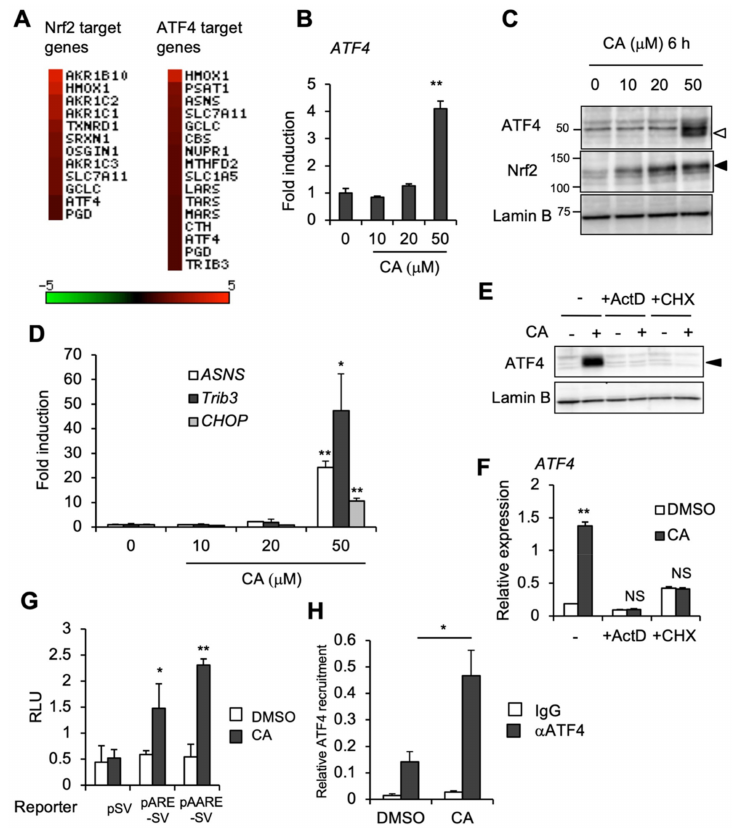
Figure 2. CA activates the ATF4 pathway in a dose-dependent manner in U373MG cells. ( A ) Heat map representation of genes induced by 50 µ M of CA in U373MG cells. The fold induction (CA vs. DMSO) was plotted based on microarray data. ( B ) Dose-dependent induction of ATF4 mRNA. ATF4 mRNA expression was evaluated by RT-qPCR and presented as the mean ± SE from three independent experiments. Each value was normalized to cyclophilin A expression. The asterisks indicate a significant increase compared with the 0 h control (** p < 0.01 by one-way ANOVA with Tukey–Kramer post hoc test). ( C ) CA dose-dependent induction of ATF4 and Nrf2 proteins. U373MG cells were administered 10 to 50 µ M of CA for 6 h. An aliquot of nuclear extract was subjected to immunoblot analysis. White and black triangles indicate ATF4 and Nrf2 bands, respectively ( D ) CA dose-dependent induction of ATF4 target gene; mRNA expression of ASNS , Trib3 , and CHOP was evaluated as described in (B). The asterisks indicate a significant increase compared with the control (0 µ M) (* p < 0.05; ** p < 0.01 by one-way ANOVA with Tukey–Kramer post hoc test). ( E ) U373MG cells were pretreated with DMSO (-), 1 µ g/mL actinomycin D (ActD) or 1 µ g/mL cycloheximide (CHX) for 30 min, followed by DMSO or 50 µ M of CA for 6 h for immunoblot analysis or ( F ) 24 h for RT-qPCR analysis. Black triangle indicates ATF4 band. The asterisks indicate a significant difference between DMSO- vs. CA-treated samples (** p < 0.01; NS not significant by one-way ANOVA with Tukey–Kramer post hoc test). ( G ) AARE-luc reporter gene activation by CA. U373MG cells were transfected with either pSV-Luc (pSV), pARE-SV-Luc (pARE-SV), or pAARE-SV-Luc (pAARE-SV) reporter vector and then incubated for 24 h in the presence of DMSO (open bars) or 50 µ M of CA (closed bars). The firefly luciferase activities were normalized to Renilla luciferase activities and presented as relative luciferase units. The values are presented as the mean ± SE. The asterisks indicate a significant increase compared with the DMSO control (* p < 0.05; ** p < 0.01 by Student’s t -test ( n = 3)). ( H ) CA-dependent ATF4 accumulation with the AARE sequence of human ASNS gene. U373MG cells were treated with either DMSO or 50 µ M of CA for 6 h and then subjected to ChIP analysis using control IgG (IgG) (open bars) and anti-ATF4 antibody ( α ATF4) (closed bars). The relative accumulation levels of ATF4 to the ASNS gene AARE are presented as the mean ± SE. The asterisks indicate a significant increase compared with the DMSO control (* p < 0.05 by Student’s t